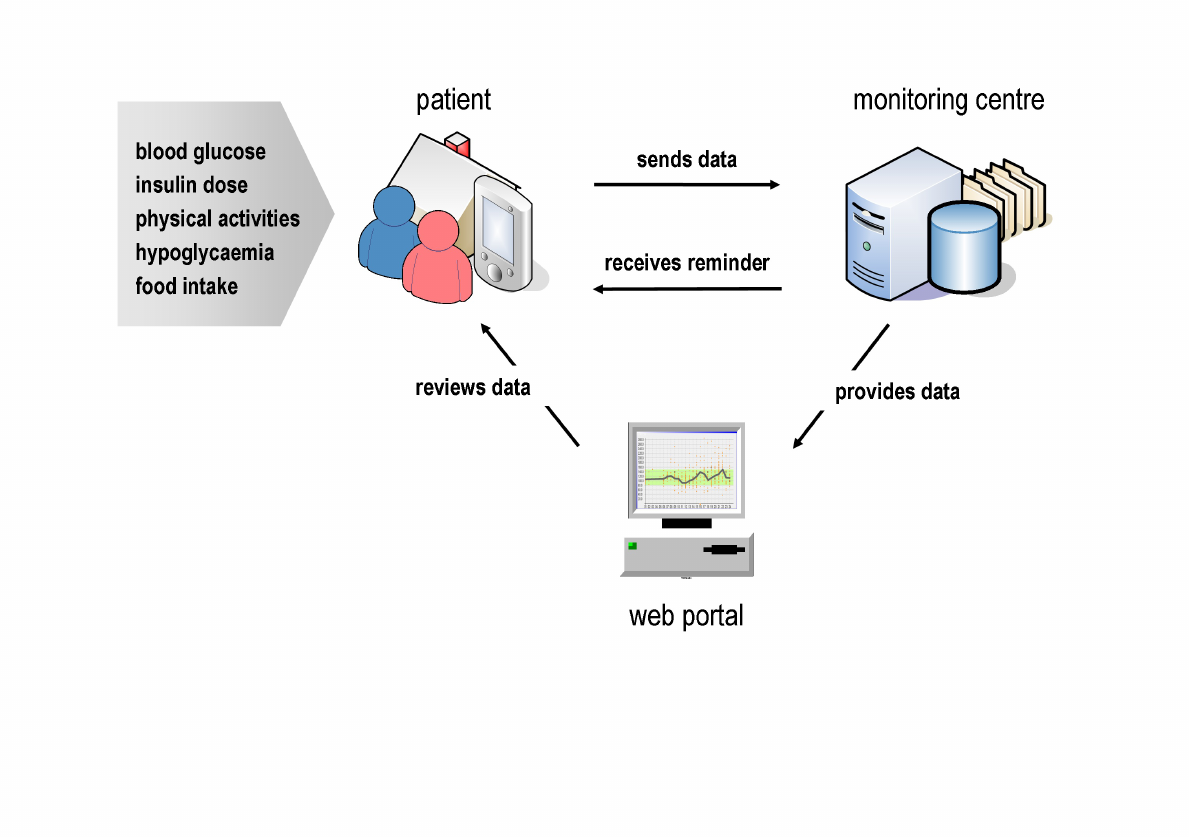
Figure 1. Overview of the mobile phone–based diabetes self-management